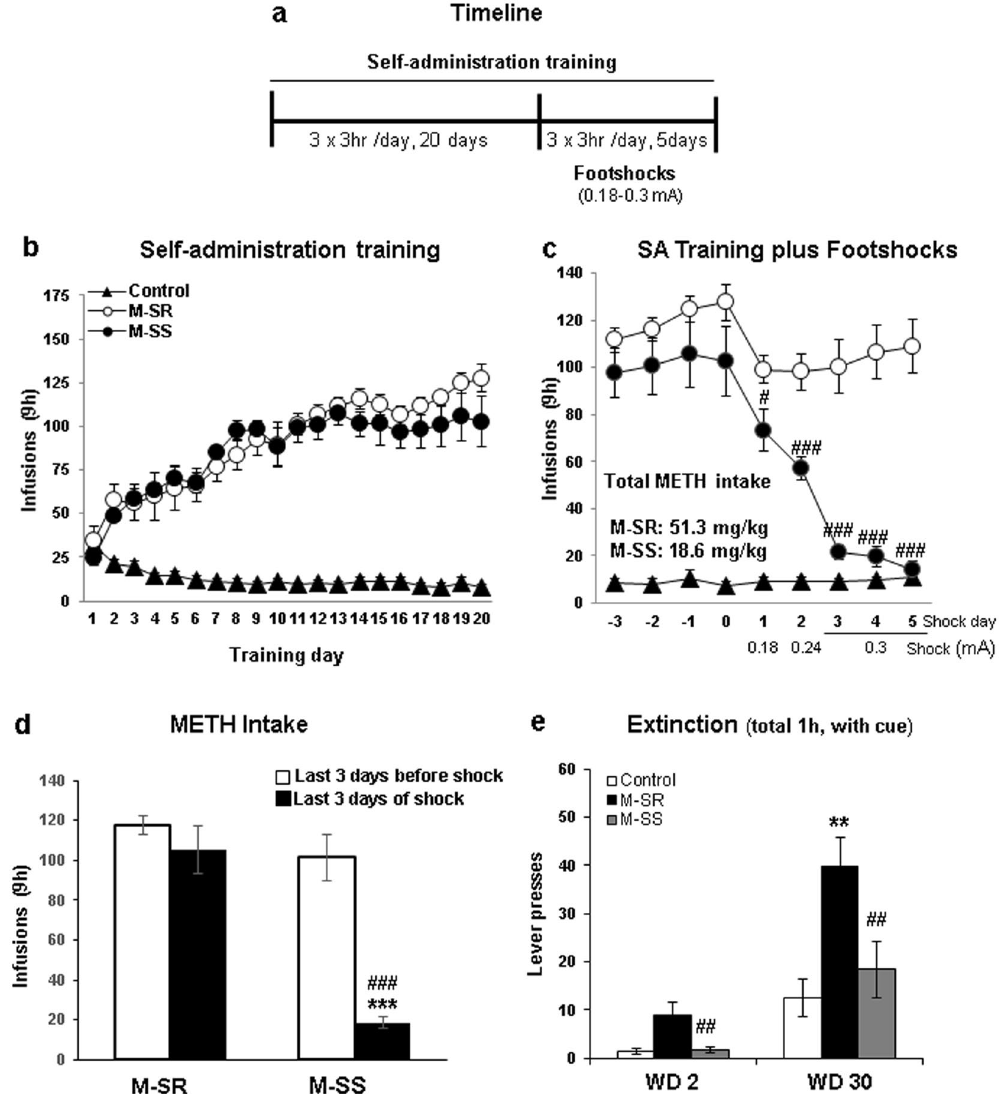
Figure 1. Extended access to methamphetamine and footshock punishment lead to compulsive methamphetamine taking or abstinence in rats. ( a ) Timeline of behavioral experiments. ( b ) Rats with long access to METH escalate drug self-administration. The groups were separated post-facto based on their responses to footshocks. ( c ) Increasing footshock intensity leads to reduction of METH intake in SS but not in SR animals. ( d ) Mean drug intake on the last 3 days of METH SA compared to last 3 days of shocks. ( e ) Rats show incubation of METH craving at withdrawal day (WD) 30 in comparison to WD2. SR rats showed higher lever pressing at WD30 in comparison to the SS